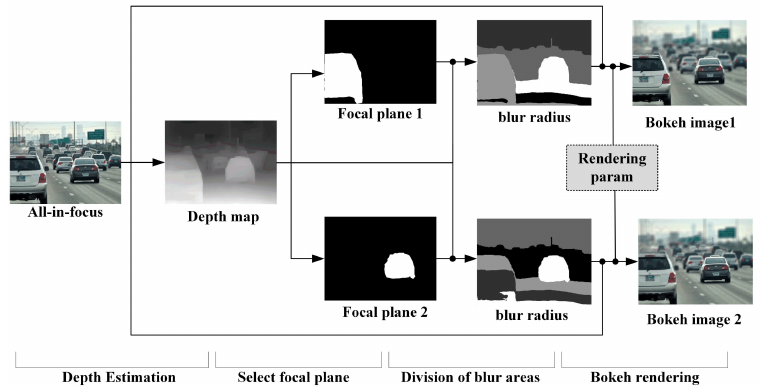
Figure 2. The overview of the bokeh-effect-rendering system.